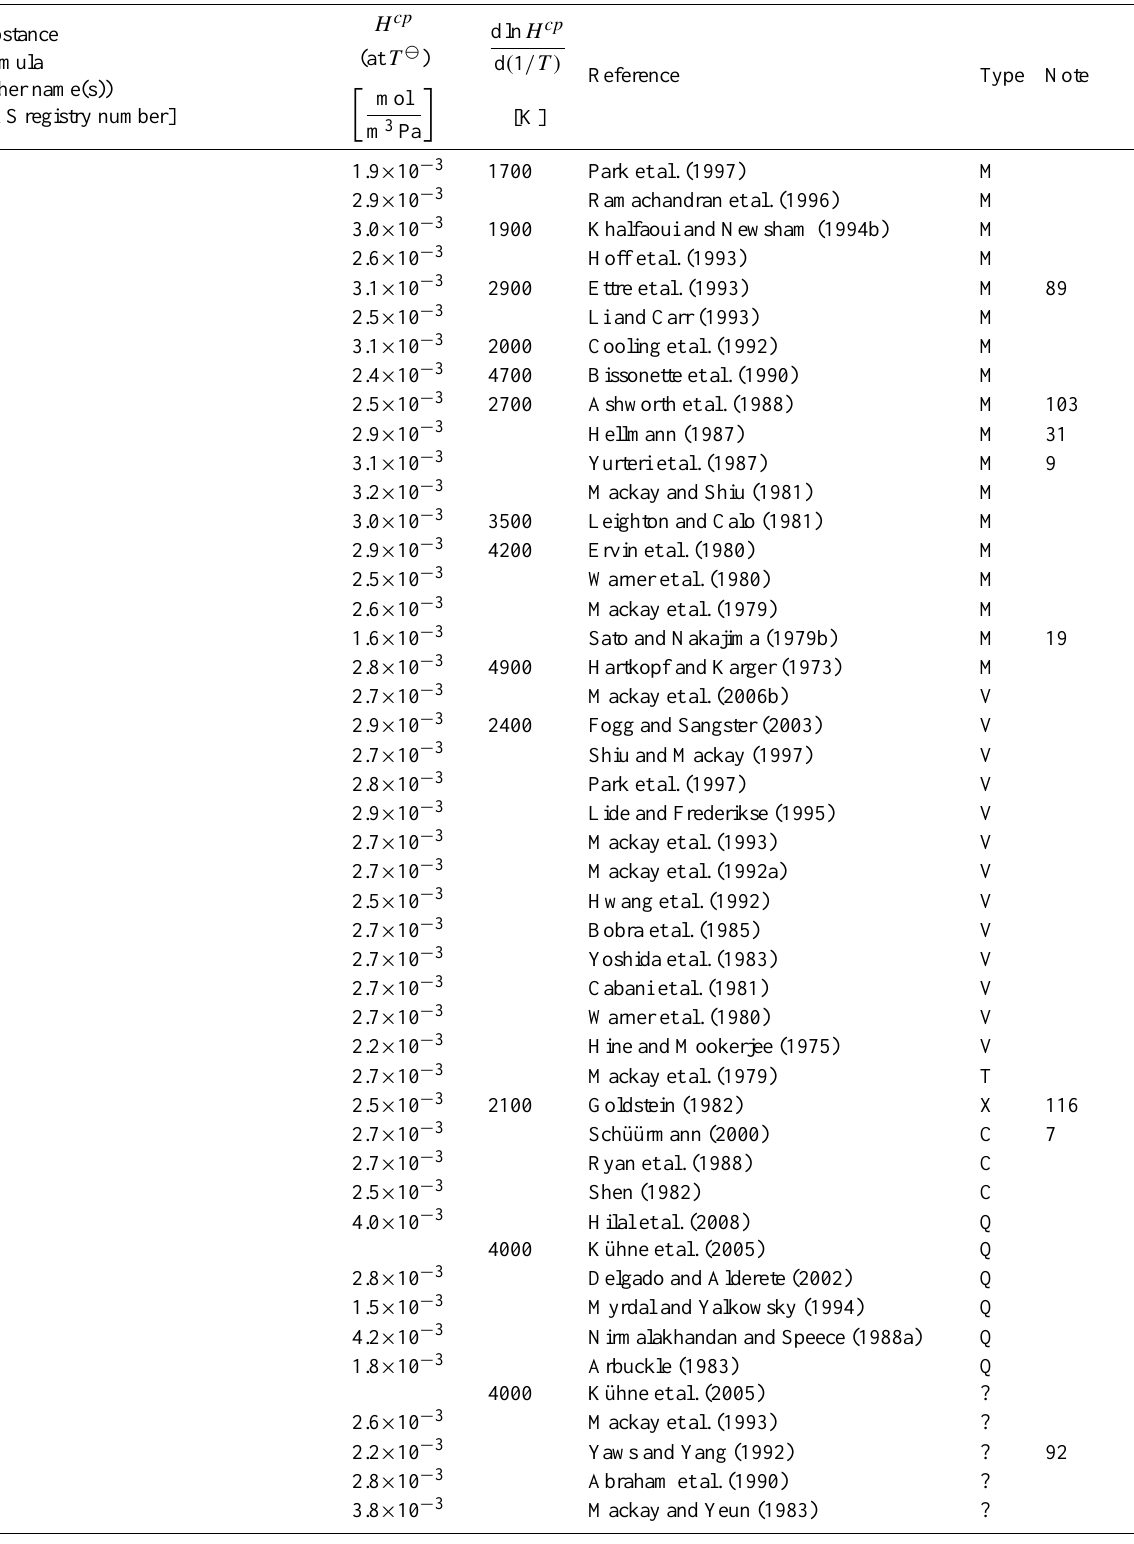
Table 6: Henry’s law constants for water as solvent